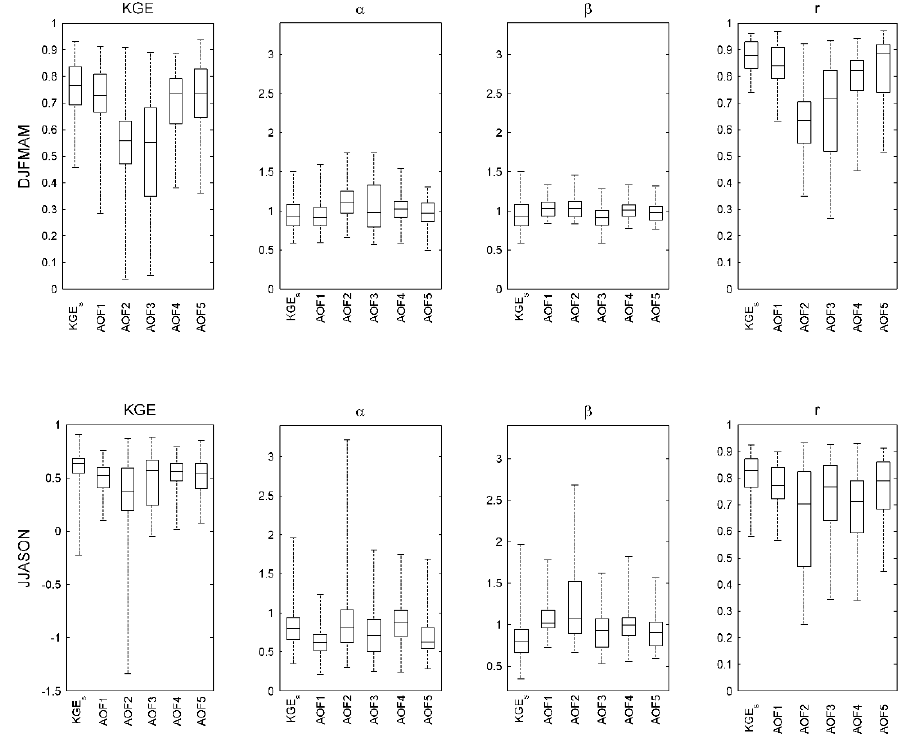
Figure 6. Hydrologic annual performance over the validation period for Du Loup, Nicolet Sud-Ouest and De l’Achigan catchments ( n = 60). Calibration is operated with a seasonal variation of the Kling– Gupta efficiency (KGE s ) metric and asynchronous objective functions AOF1 to AOF5 . Performance is expressed in terms of KGE metric and its variance ( α ), bias ( β ), and correlation ( r ) components from December to May (DJFMAM) and June to November (JJASON).